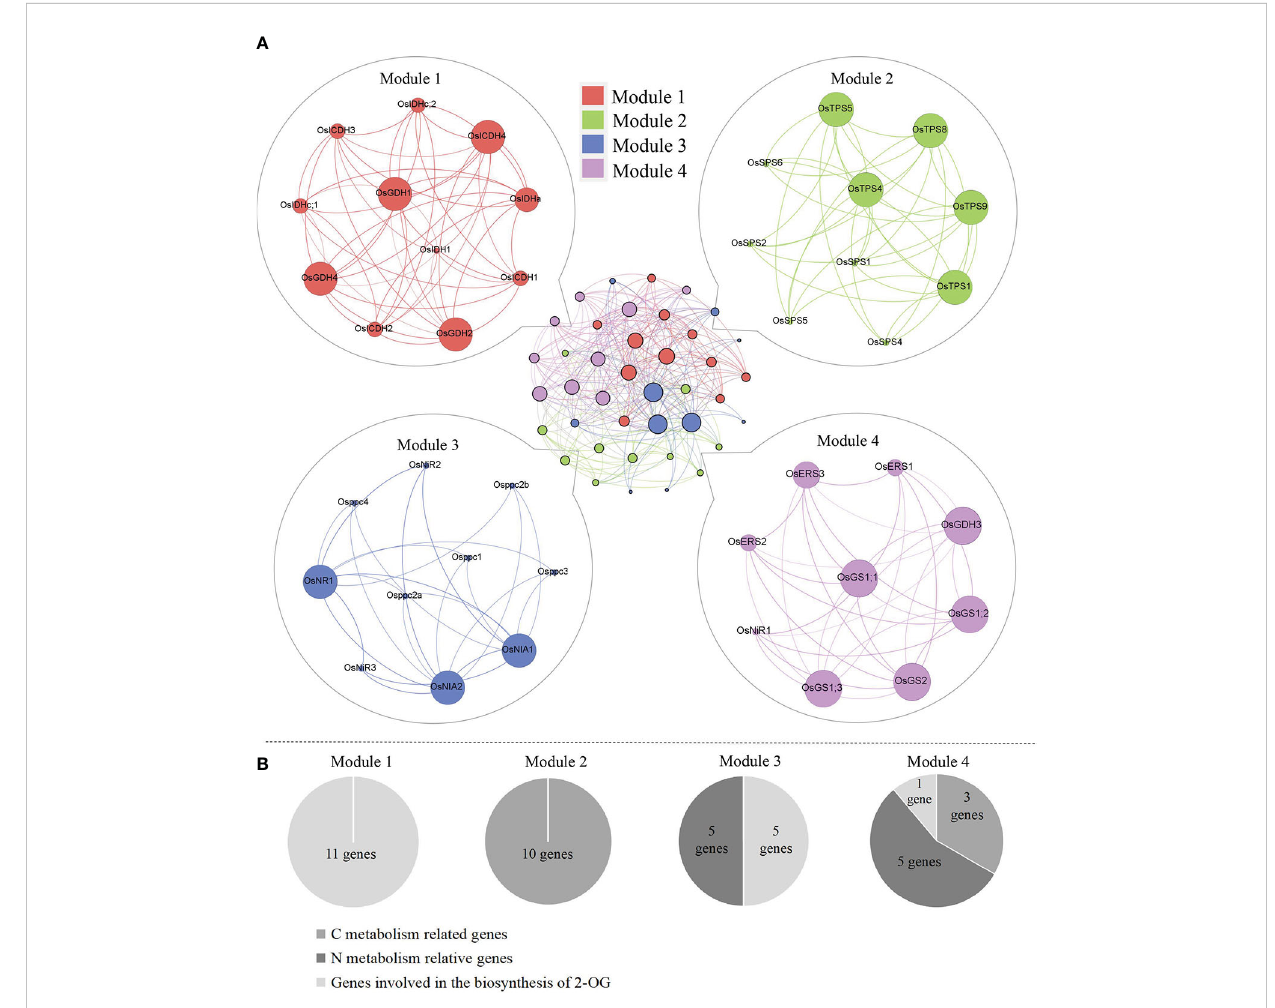
FIGURE 4 (A) Genetic matrix integrative analysis of CNM-related genes. (B) The number of CNM genes in each matrix. CNM, carbon, and nitrogen